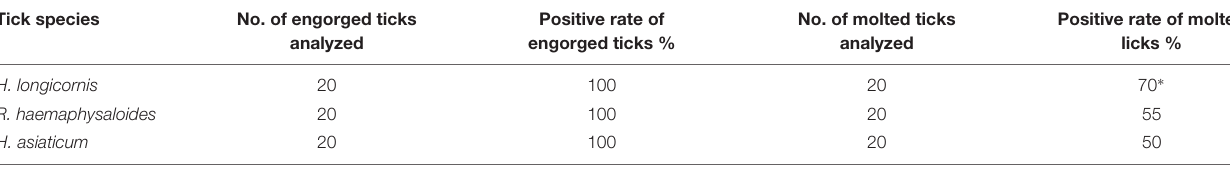
TABLE 3 | Infection of nymphal ticks by exposure to mice infected with B, microti. Tick species No. of engorged ticks